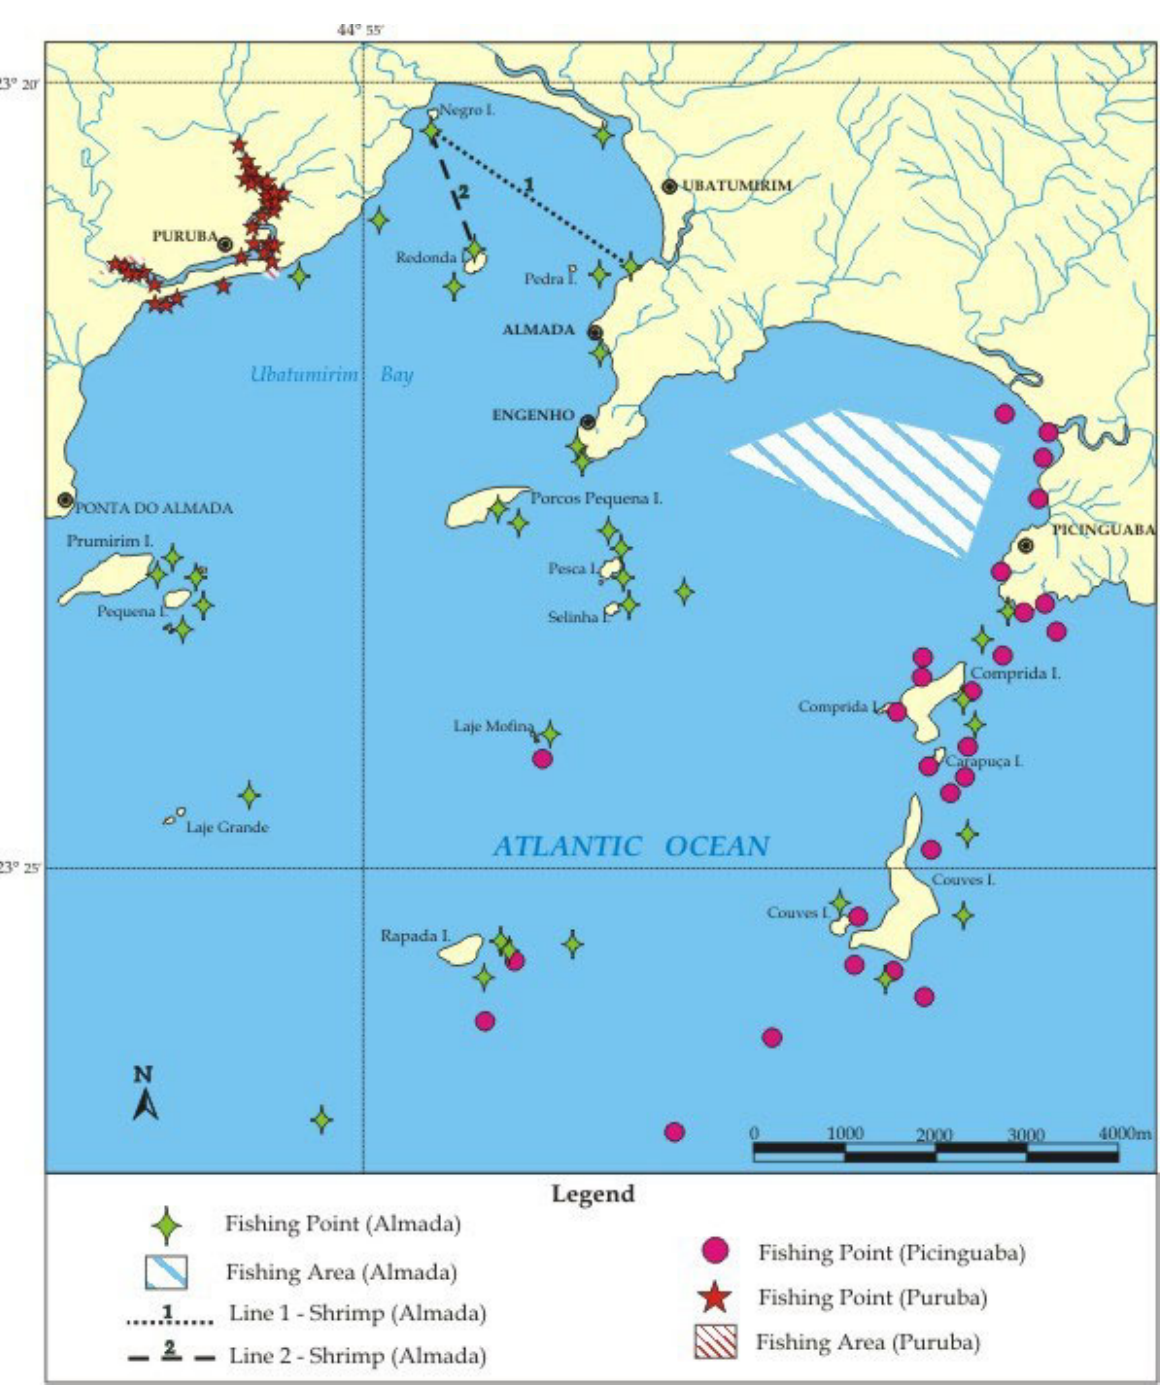
Fig. 7 . Fishing spots marked at Picinguaba by two informants in 2003, and at Almada-Engenho Beaches, São Paulo State in